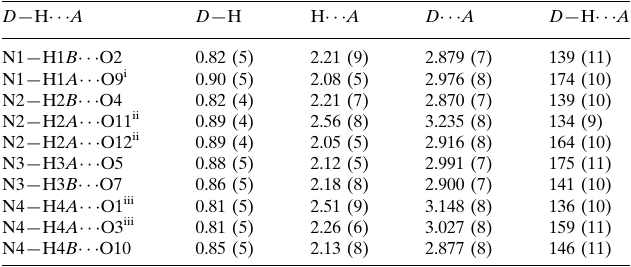
Hydrogen-bond geometry (A˚ , (cid:2)